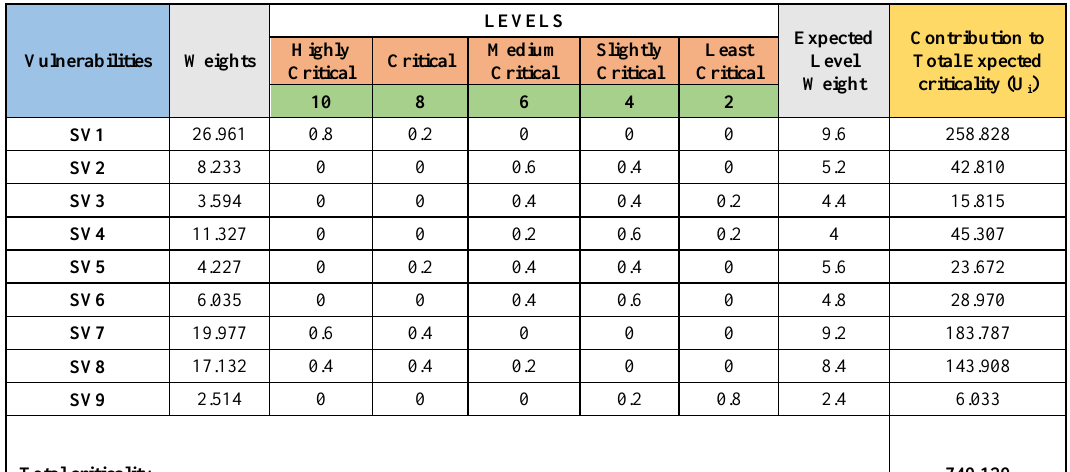
Table 6. Overall criticality measure of